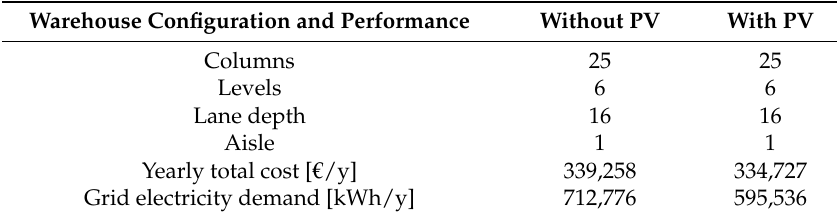
Table 3. Optimal warehouse configuration with and without PV plant.